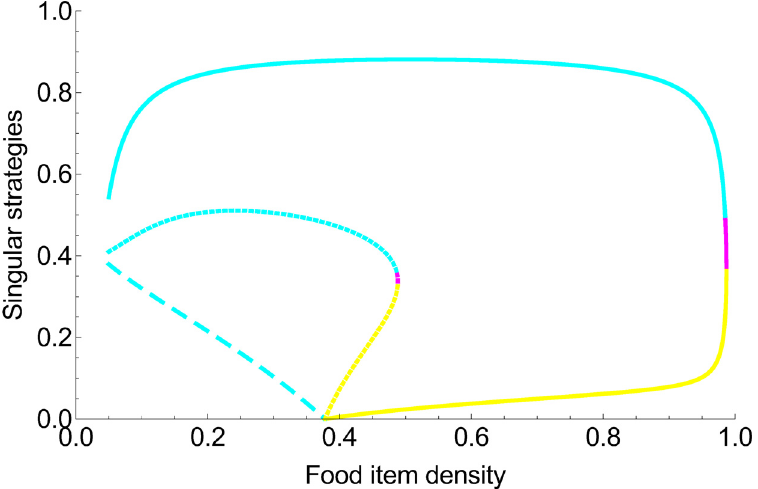
Fig 5. Singular strategies x (degree of collective foraging) and their stability as a function of food item density. The cyan lines represent continuously stable strategies (evolutionarily and convergence stable), the yellow lines represent repellors (neither evolutionarily nor convergence stable), and magenta lines represent branching points (evolutionarily unstable and convergence stable). The values and statuses of the singular strategies are plotted for different competition scenarios: the dashed lines represent symmetric competition ( ϕ = 0); the dotted lines represent weakly asymmetric competition ( ϕ = 1); and full lines represent strongly asymmetric competition ( ϕ = 5).